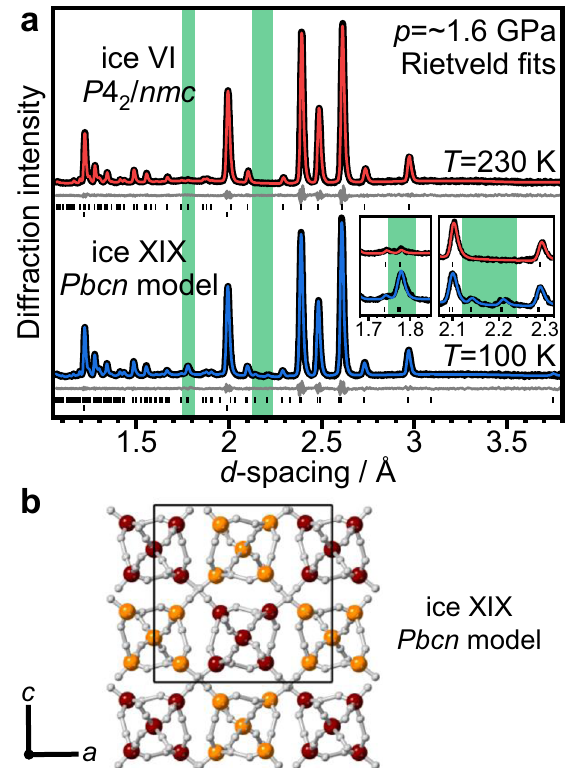
Fig. 2 Analysis of the diffraction data of DCl-doped D 2 O ice VI samples collected at 1.6 GPa. a Rietveld fi ts of the diffraction data collected 230 and 100 K using the P 4 2 / nmc space group for ice VI and Pbcn for ice XIX. The upper tick marks indicate the expected positions of Bragg peaks for the ice whereas the lower tick marks are from the sintered diamond anvil. The insets show the fi ts in the regions where the most major peak intensity change and the additional weak Bragg peaks are observed for ice XIX. b Crystal structure of ice XIX using the Pbcn space group. The hydrogen atoms are shown in white, and the oxygen atoms of the two individual networks in burgundy and orange,